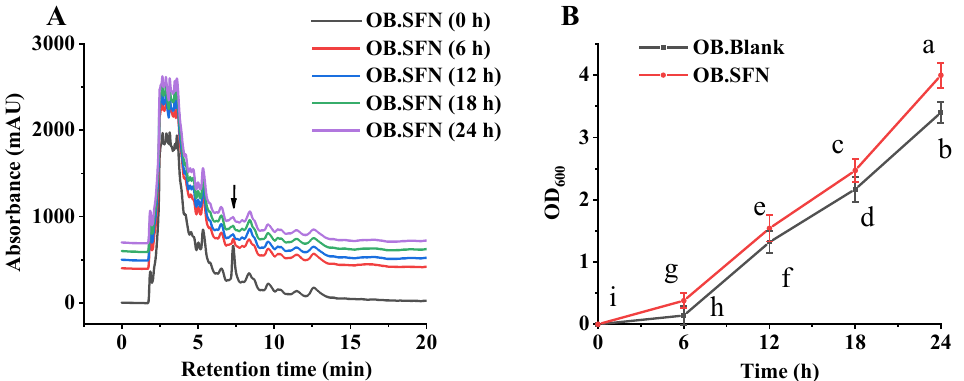
Figure 3. Changes in sulforaphane (SFN) and microflora growth during in vitro fecal fermentation. ( A ) HPLC profiles of SFN during fecal microbiota fermentation in obese patients and ( B ) microflora growth during in vitro fecal fermentation in obese patients. a–i: Mean value in the same group with different letters was significantly different ( p < 0.05) by a Tukey test. The arrows in ( A ) represent